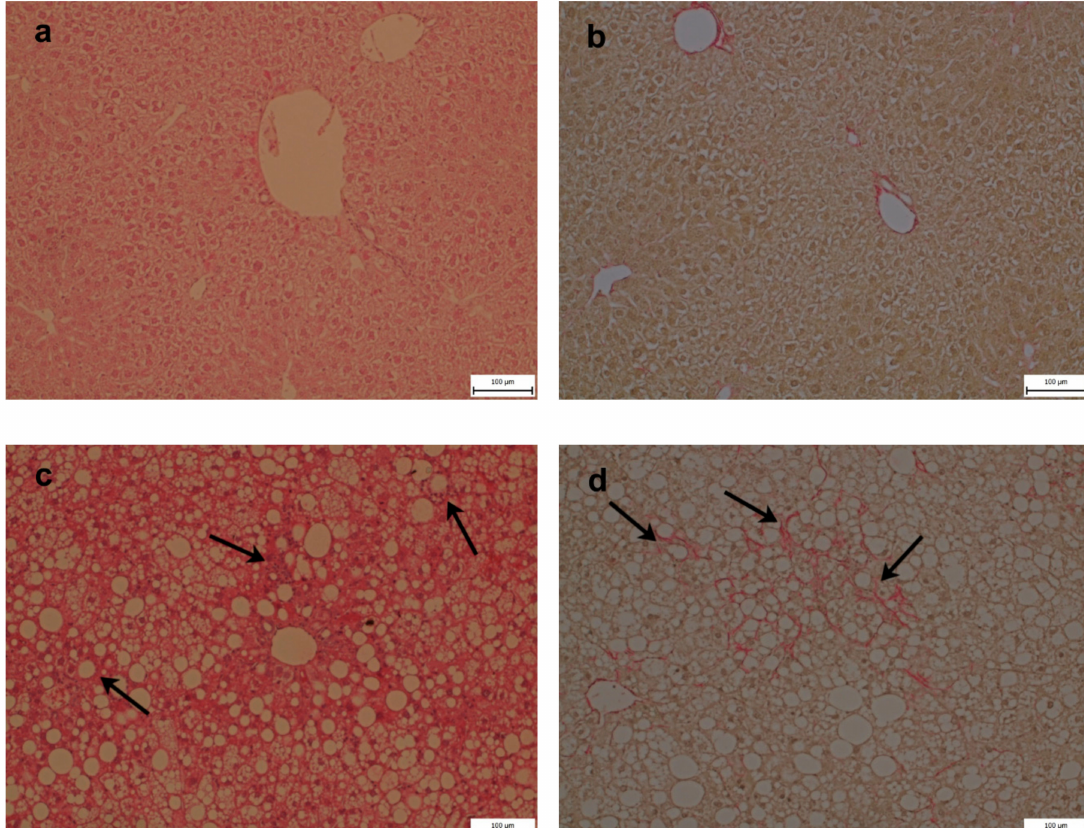
Figure 2. Liver histology ( a , b ) in mice fed a control diet (CD) and ( c , d ) Western-style diet (WD). ( a , c ) Hematoxylin and eosin sections of mice fed a WD reveal massive mixed steatosis with inflammatory infiltrated cells indicated by arrows. ( b , d ) Sirius red staining revealed mild perisinusoidal fibrosis indicated by